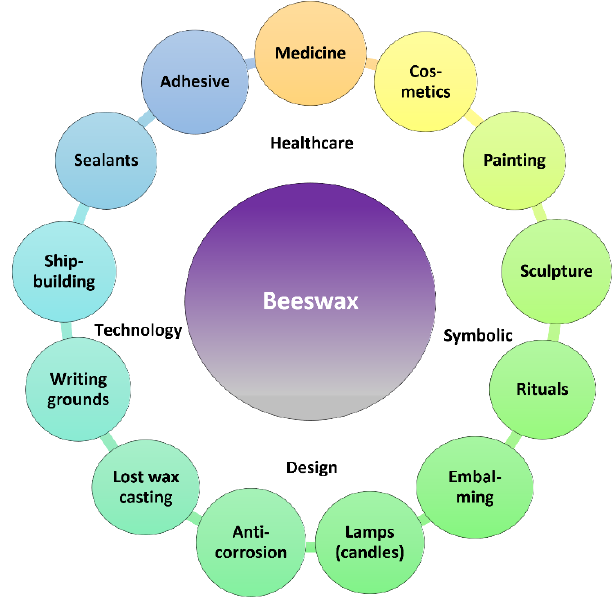
Figure 7. Application of beeswax in technological and artistic areas.